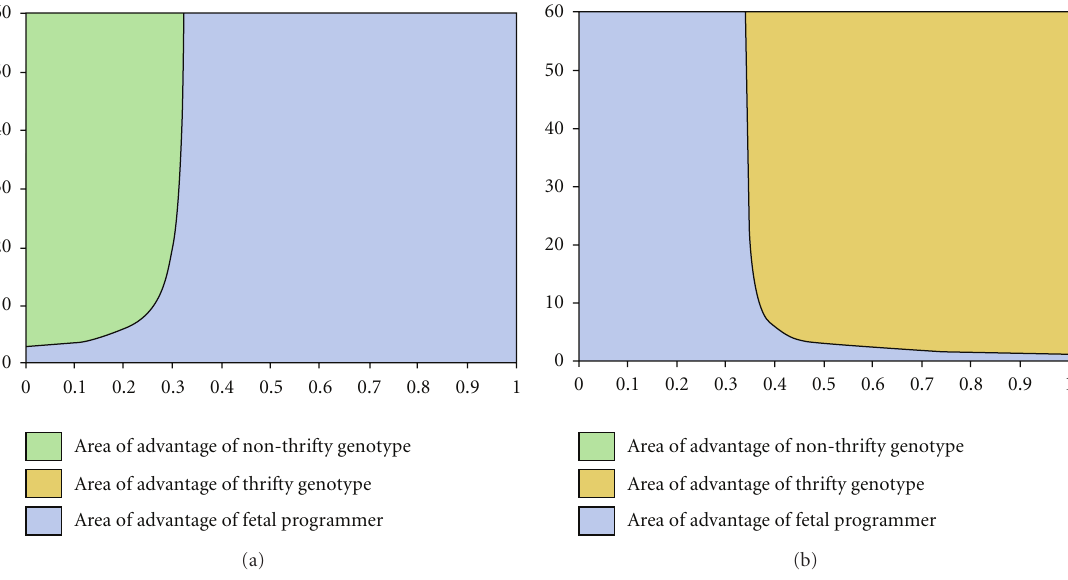
Figure 1: Parameter areas of advantage: (a) when only nonthrifty genotype and fetal programmer compete, (b) when only thrifty genotype and fetal programmer compete. For this and all other figures, ( tf1 − nf1 ) / ( nf0 − tf0 ) is maintained constant at 1.33.